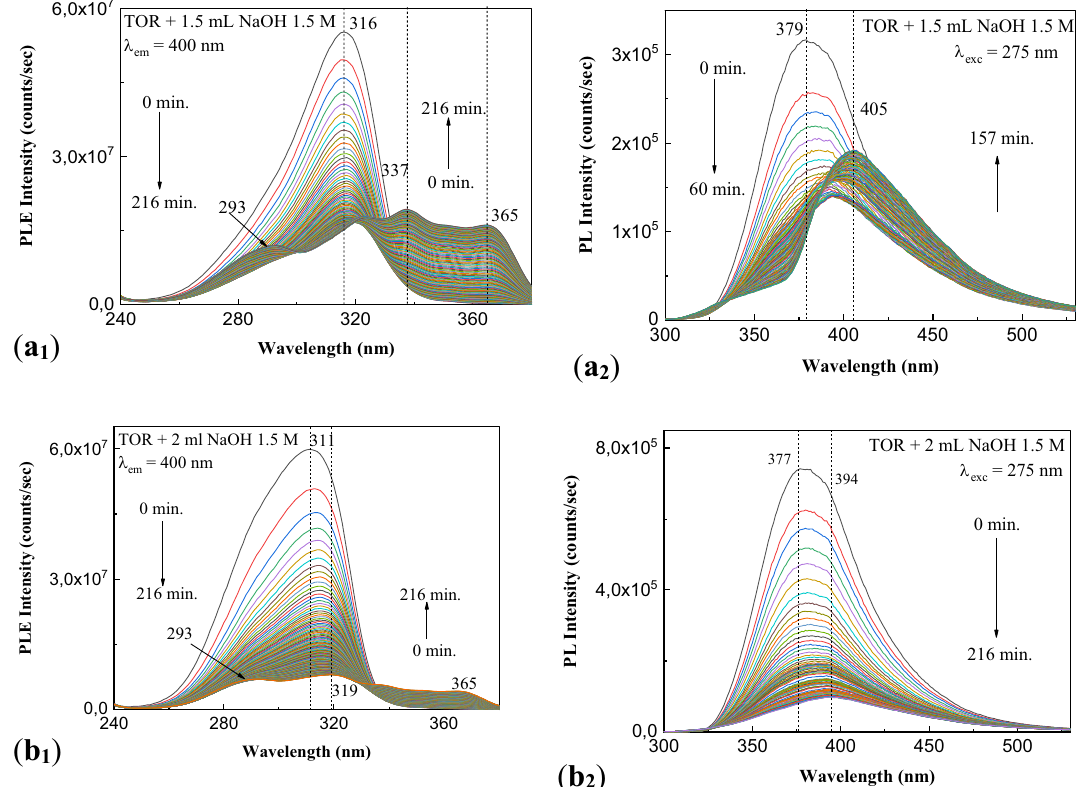
Figure 6. PLE (1) and PL (2) spectra of the aqueous solutions of: (1) 1.5 ml TOR interacted with 1.5 ml NaOH 1.5 M (